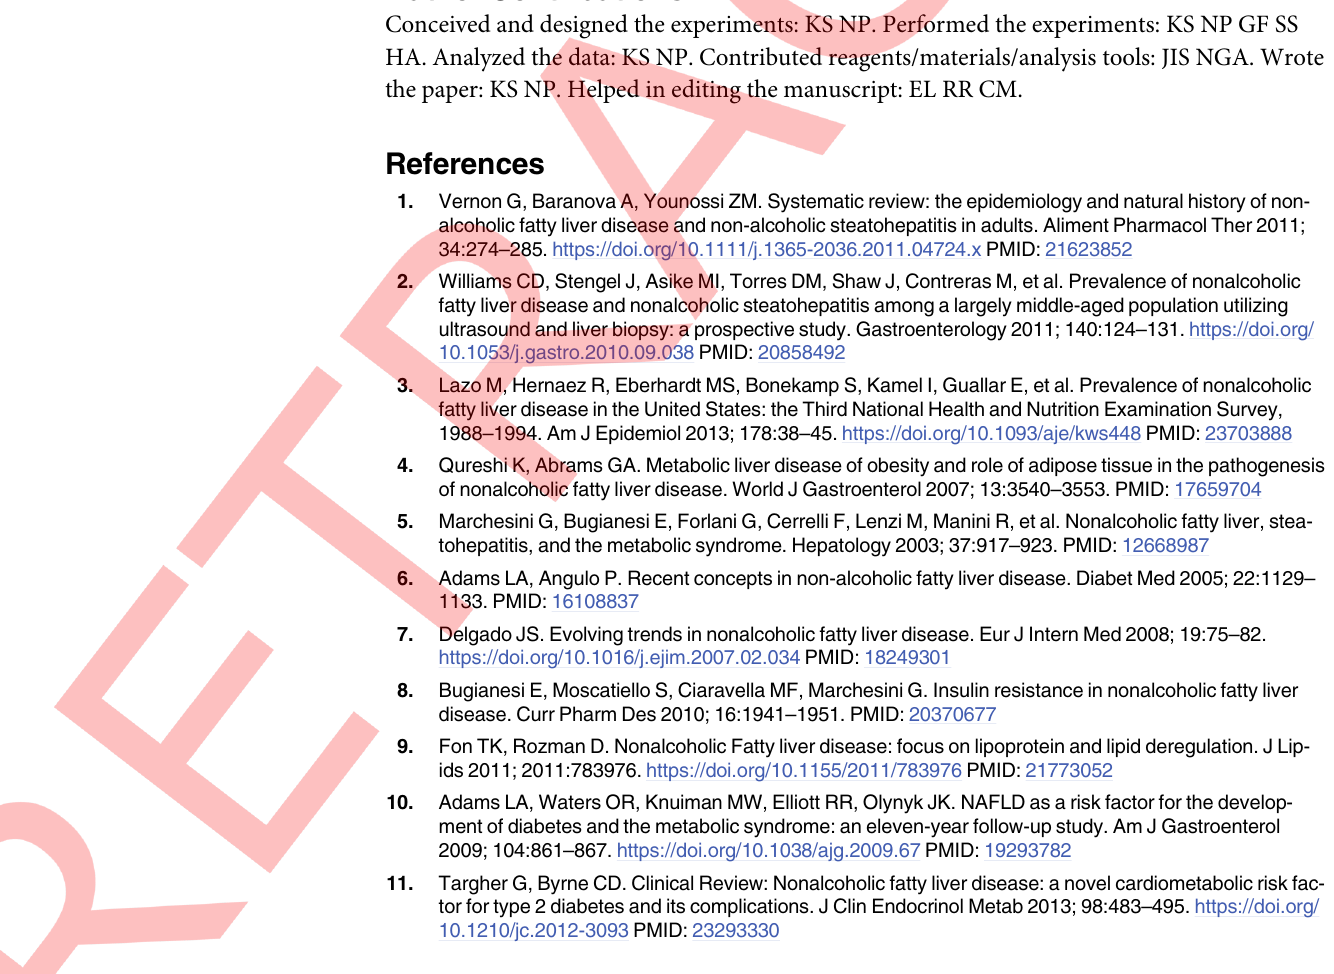
groups from Fig 2. Table C : Control groups from Fig 3. Table D : Control groups from Fig 4. Table E : Control groups from Fig 5. Table F : Control groups from Fig 6. Table G : Control groups from Fig 7. Table H : Control